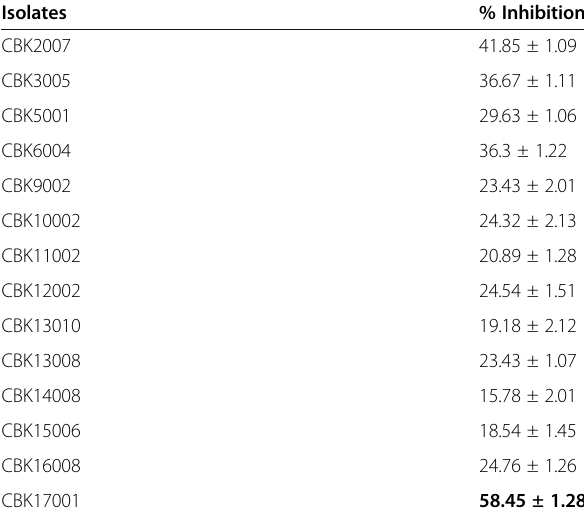
Table 1 Antagonistic activity of different isolates against Sclerotium rolfsii